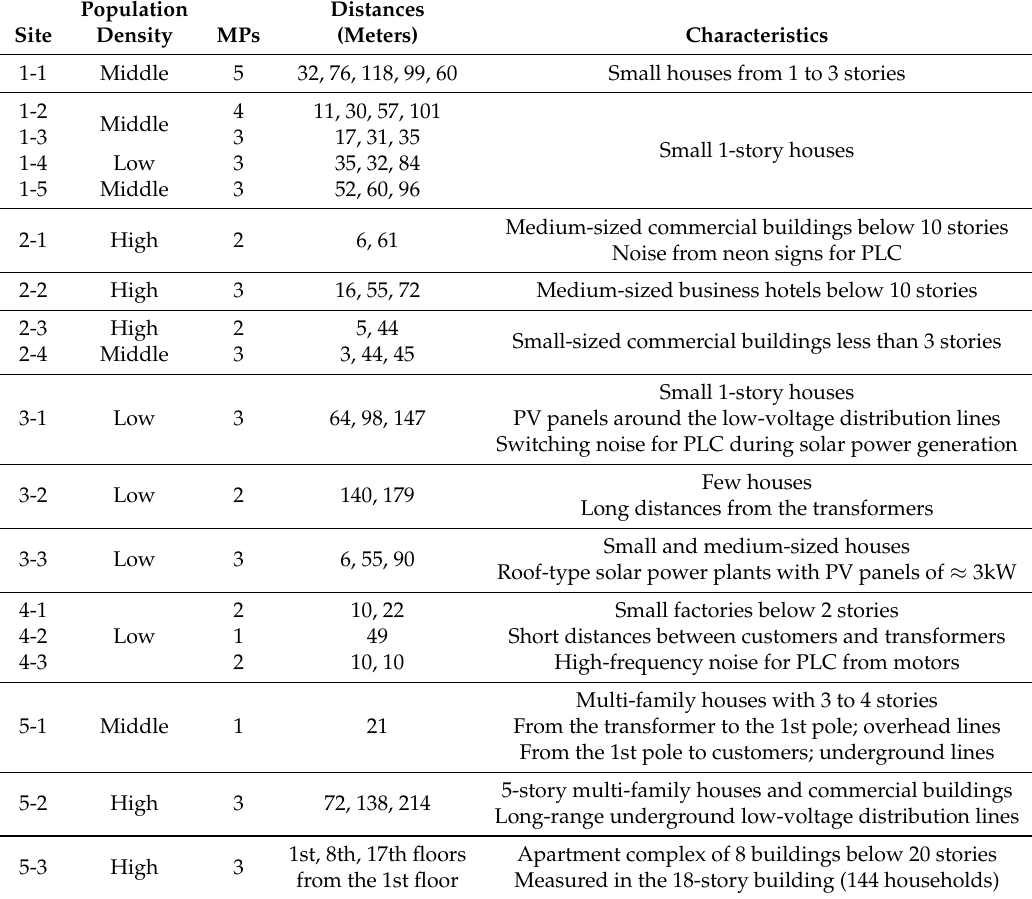
Table 1. Summary of the 18 Sites with 48 measurement points (MPs) in Figures